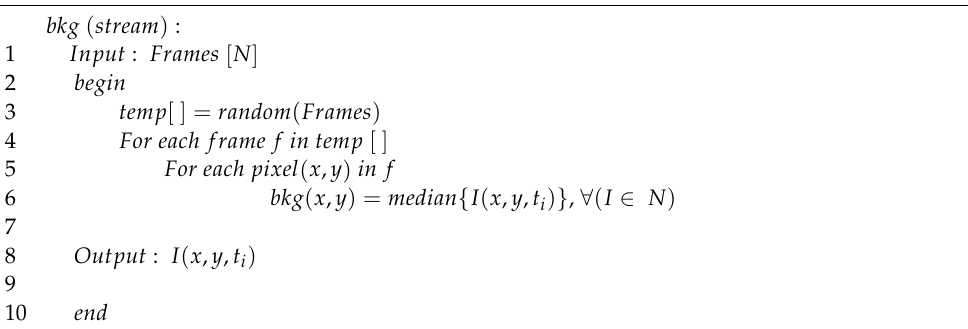
Algorithm 1 Background Modeling Abstraction Algorithm